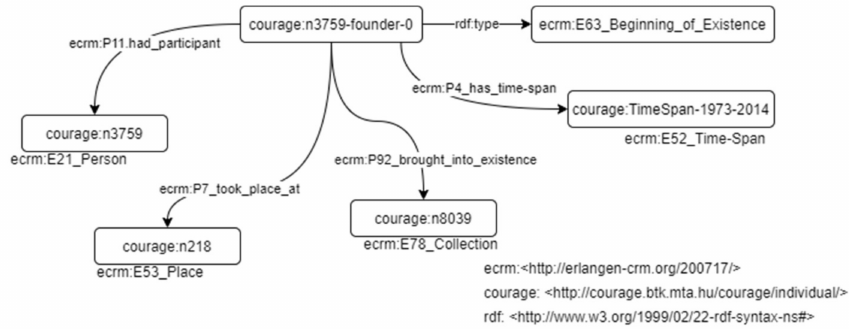
Figure 7. Founder role representation in CIDOC-CRM.